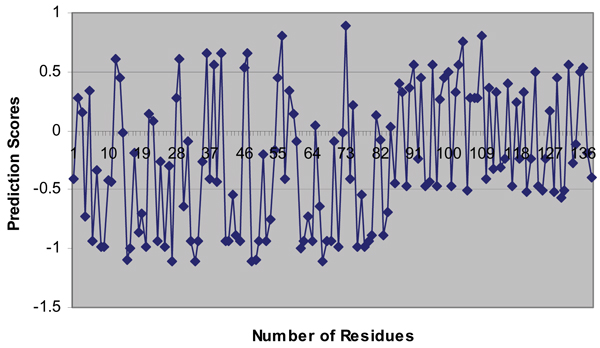
An Example of Domain Boundary Assignment by Improved DomainDiscovery. Domain Boundary is at the residue 73.